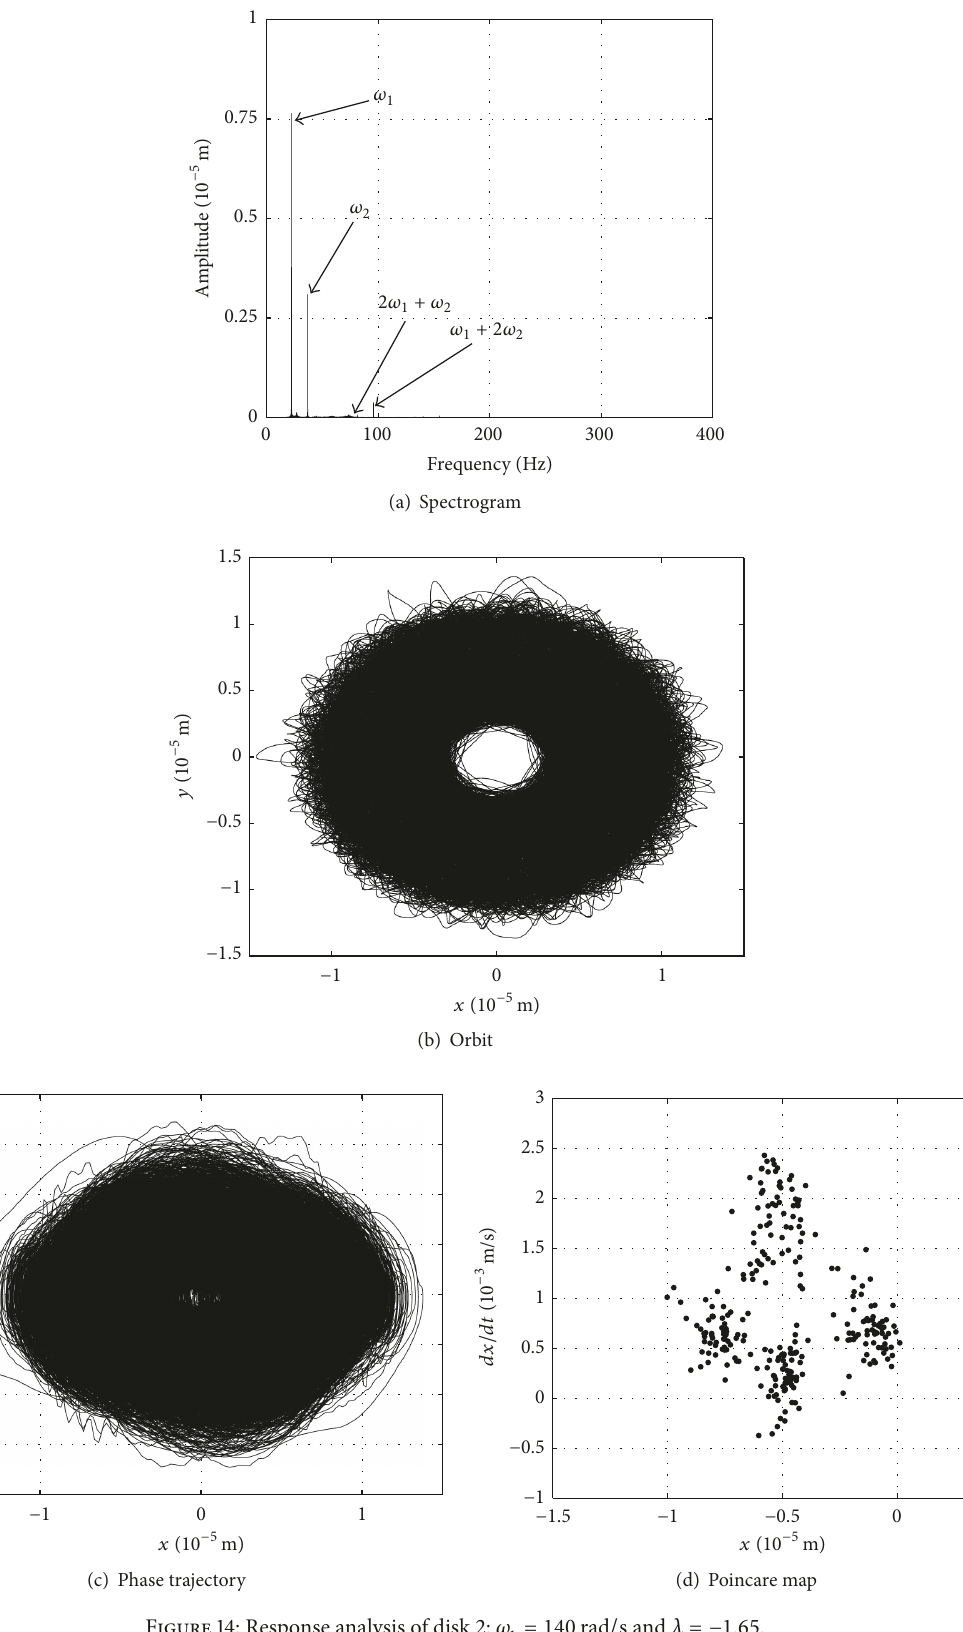
Figure 14: Response analysis of disk 2: 𝜔 1 = 140 rad / s and 𝜆 = −1.65